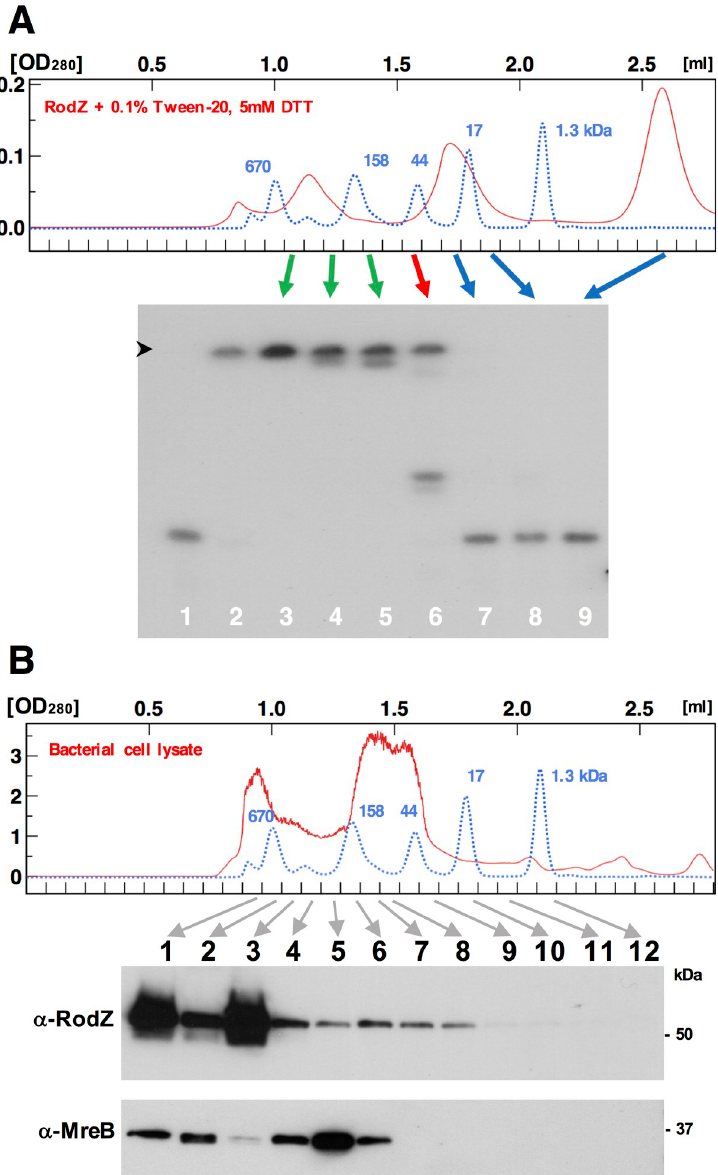
Fig 4. Multimer formation of RodZ in vitro and in vivo . (A) EMS analysis using fractions from the gel filtration column indicated in panel c of Fig 1A (Red line). The blue line indicates the superimposition of the molecular mass standards, identical to those in Fig 1A. Positions of the fractions used for EMS analysis are indicated by colored arrows. Lane 1: negative control without protein. Lane 2: positive control with unfractionated input. Black arrowhead indicates bottom of gel wells. (B) Soluble cell lysates were prepared by sonication and filtration of MS390 grown to midlogarithmic phase (OD 600 = 0.5) in 35 ml LB medium at 37˚C with shaking at 150 rpm (see Experimental procedures). Each 40- μ l sample was fractionated using a Superdex-200 PC3.2/30 column equilibrated with the RNA binding buffer containing 0.1% Tween 20 and 0.1% Triton X-100 at flow rate of 40 μ l/min (upper panel). The red line indicates the OD 280 of the sample. The blue line indicates the superimposition of the molecular mass standards, identical to those in Fig 1A. Fractions indicated with arrows were subjected to immunoblotting using the anti-RodZ monoclonal antibody 5–17 and anti-MreB polyclonal antibody on the same blot of 10% SDS-PAGE (lower panels). Experiments were performed at least three times with similar results. Representative data are shown.